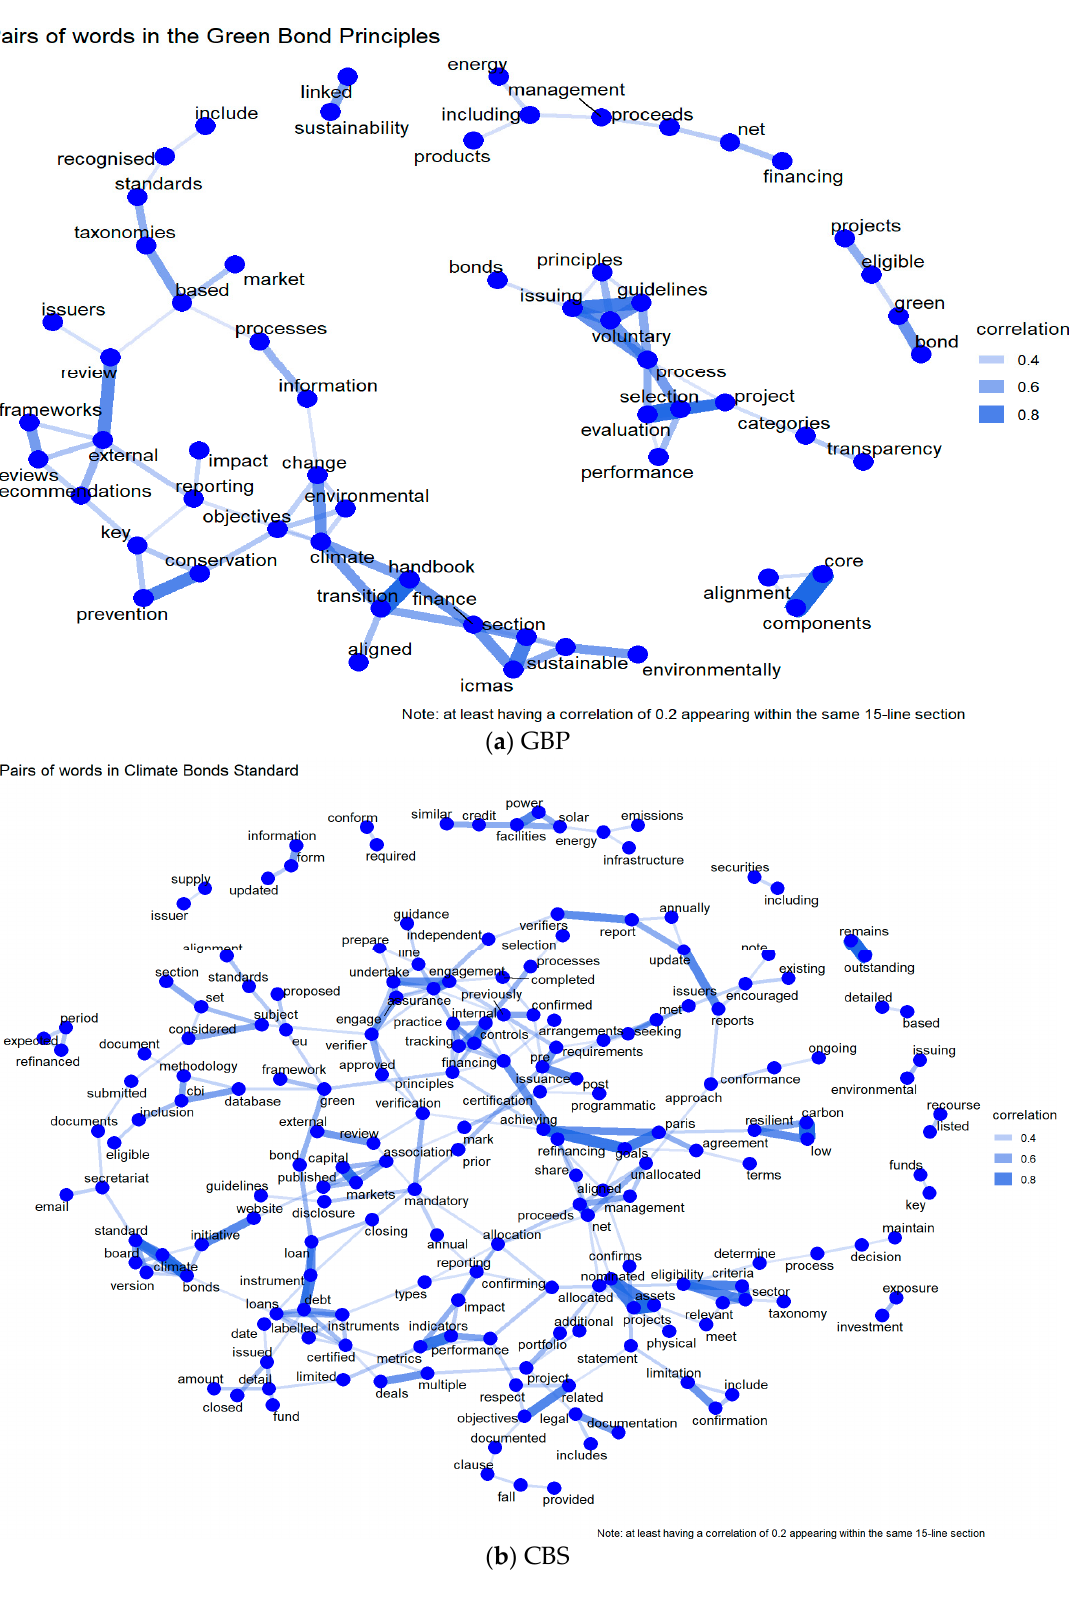
Figure 6. Network matrix for the international GB guidelines .